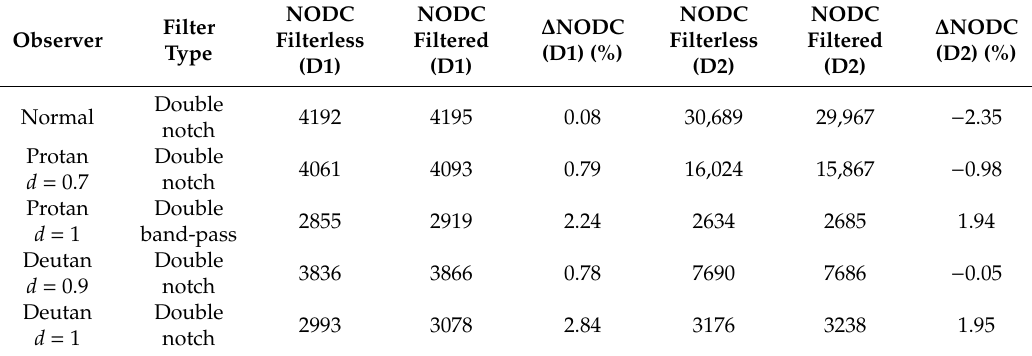
Table 1. Number of discernible colors (NODC) before and after filtering with the best-performing filter chosen for each observer and the relative increase for both dataset D1 (Atlas) and D2 (scenes).